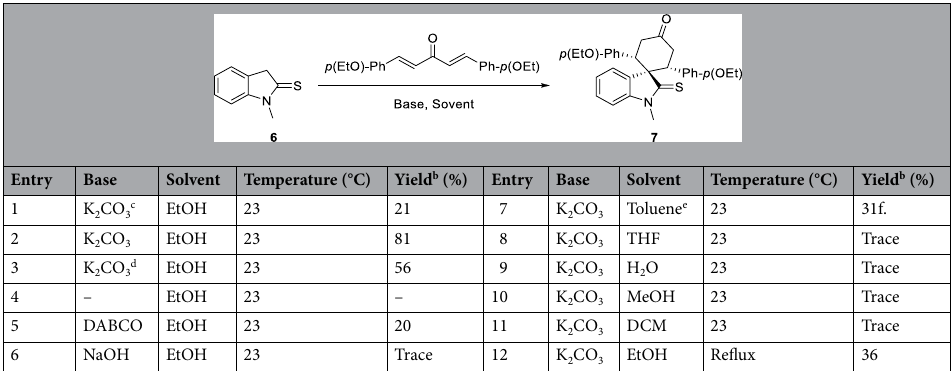
Table 2. Optimization of the double Michael addition reaction conditions. a 0.5 mmol thiooxindole (1.0 eq),